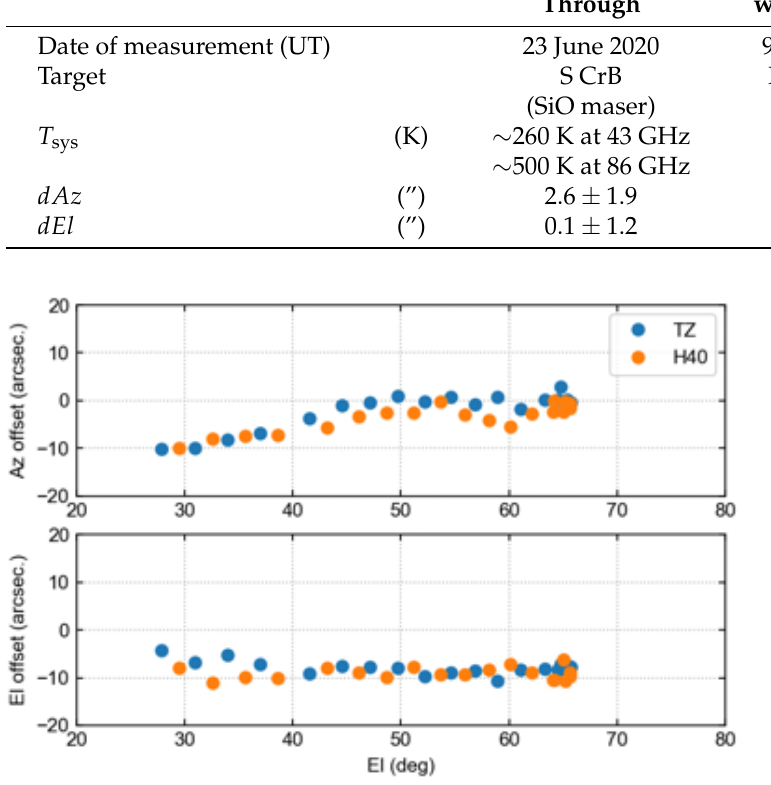
Table 4. Summary and result of beam squint measurement in 86-GHz observing system. Through with Filters at #8 & #9